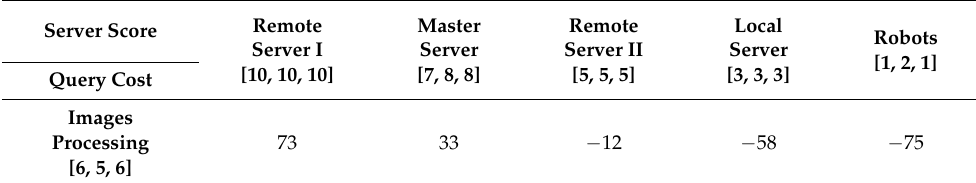
Table 7. SAAQ performance scores for our Motivating